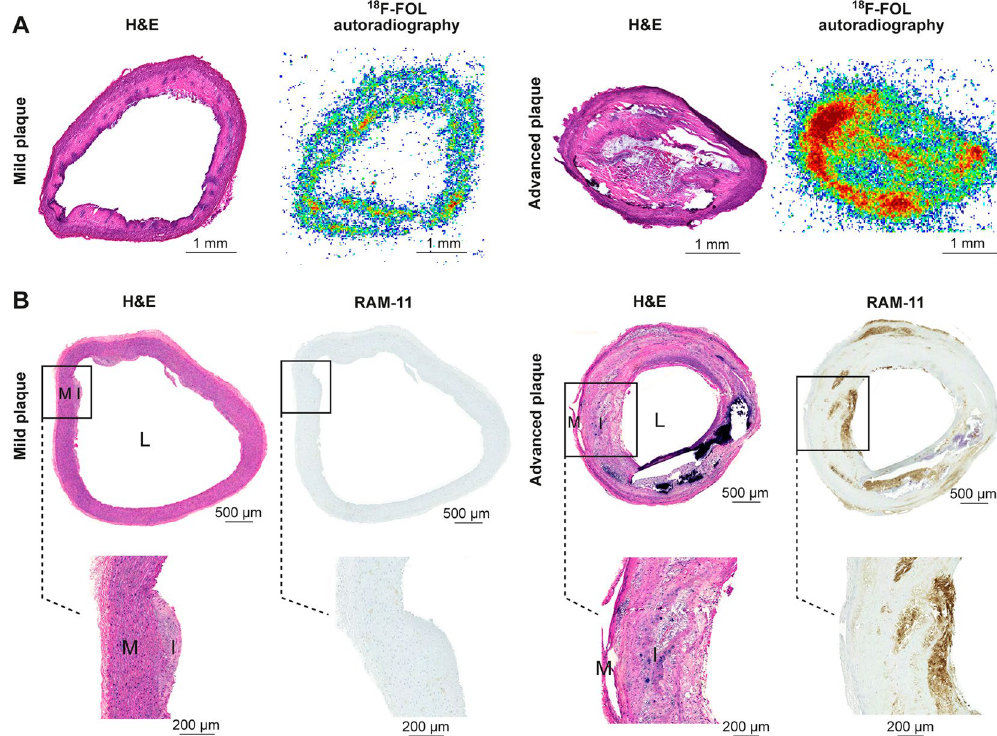
Figure 7. 18 F-FOL uptake, histology and immunohistochemistry of rabbit aorta. Representative ( A ) hematoxylin-eosin (H&E) stained cryosections and 18 F-FOL ex vivo autoradiography images, and ( B ) H&E and RAM-11 immunohistochemistry (macrophages) images of mild intimal thickening and advanced atherosclerosis in rabbit aorta. M = media; I = intima; L = lumen. The images on the bottom show high-power views of the area within the black rectangle on the upper